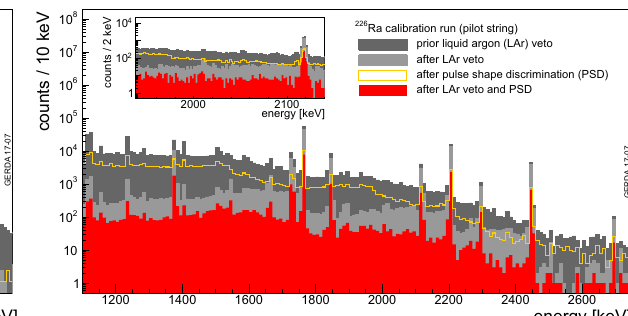
shows the double escape peak of 208 Tl at 1593keV and the 1621keV single gamma line of 212 Bi, on the r.h.s the 2118keV single gamma line of 214 Bi